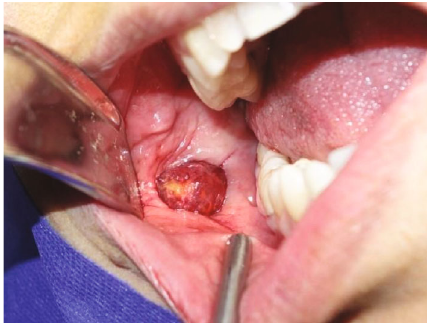
Figure 5: Image shows gross specimen, a spherical brown-gray fi rm tissue, measuring 1cm in